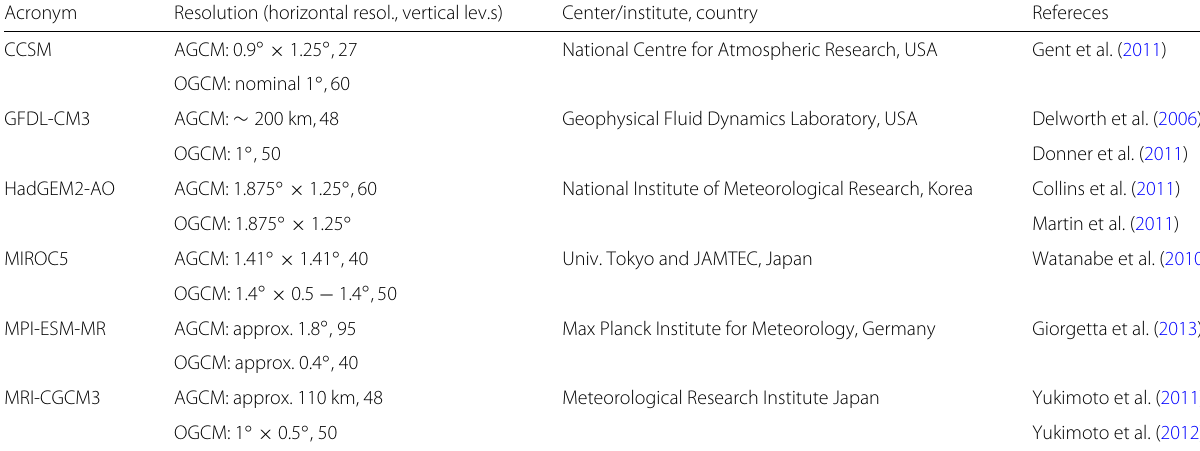
Table 2 List of CMIP5 models whose future climate projections are used in d4PDF. Please refer to Appendix 9.A of the IPCC Fifth Assessment Report (the Working Group I) for further details Acronym Resolution (horizontal resol., vertical